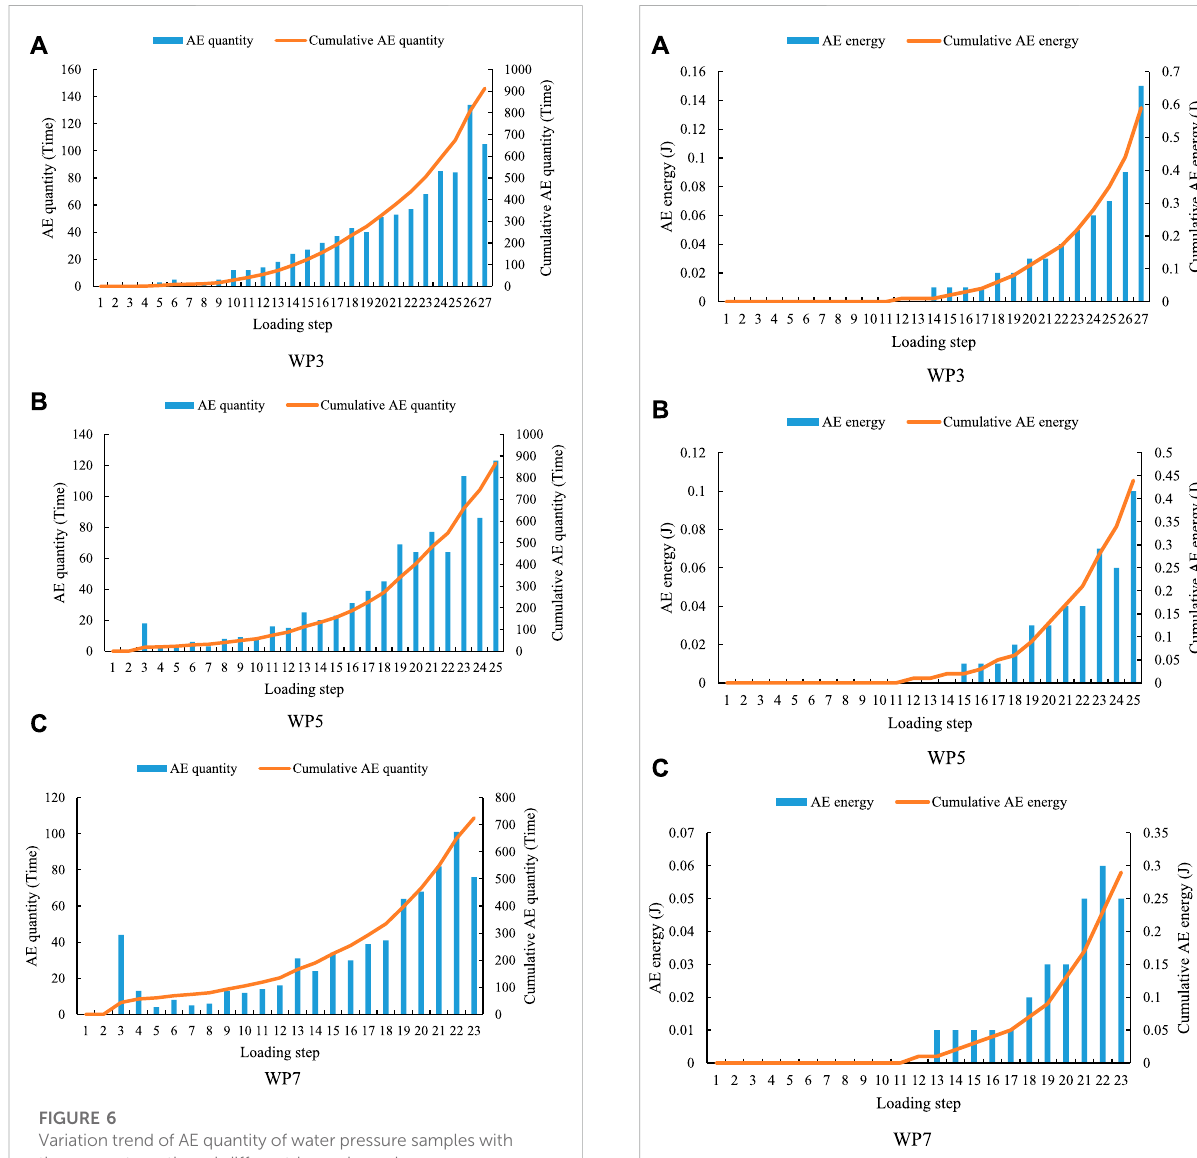
FIGURE 6 Variation trend of AE quantity of water pressure samples with the same strength and different lower boundary.